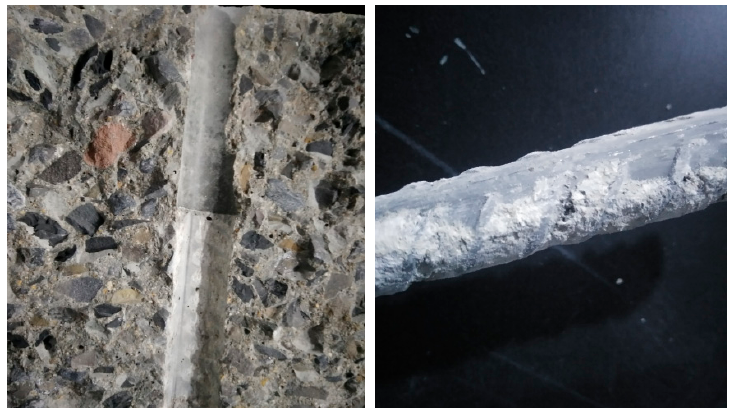
Figure 5. Diagram of pull-out damage.